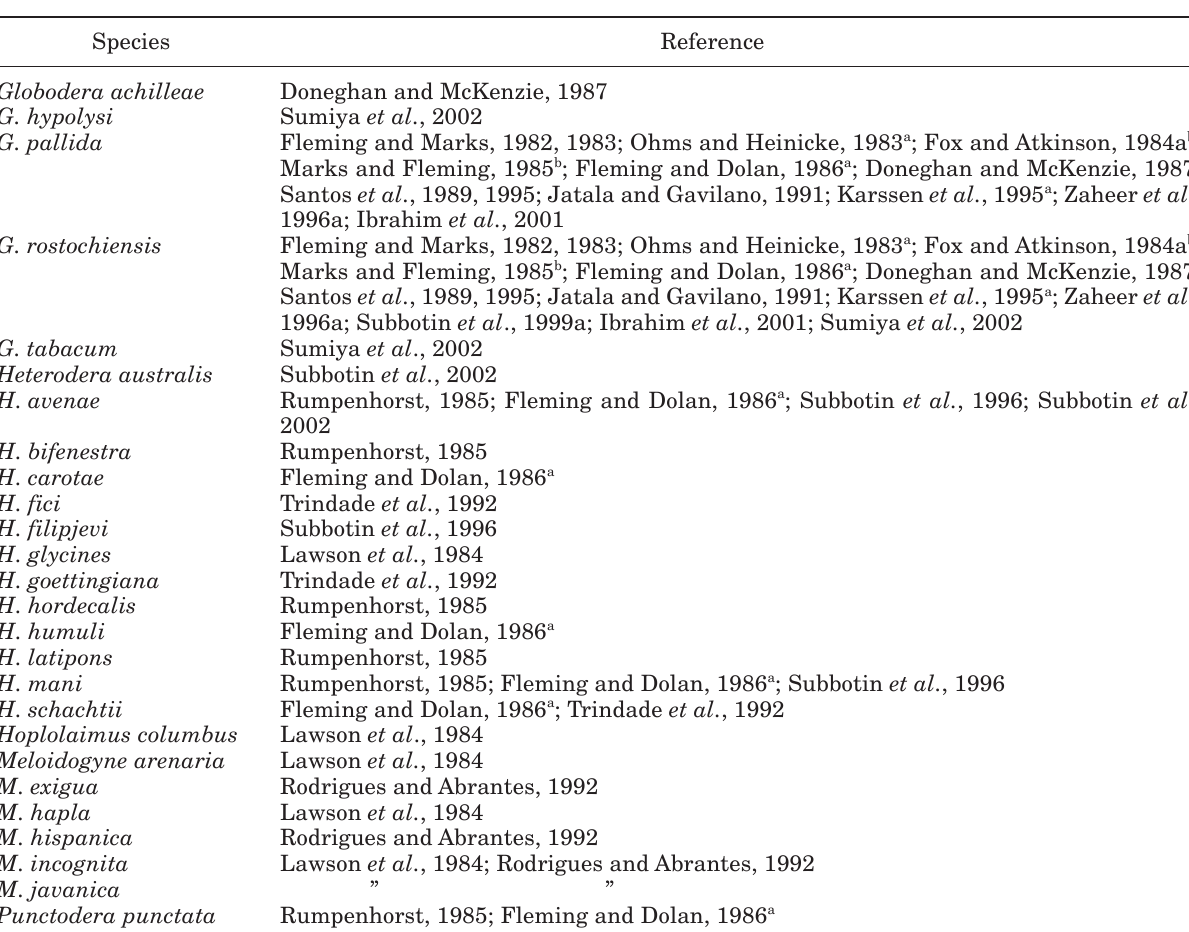
Table 5. Plant-parasitic nematode species characterized on the basis of proteins, using isoelectric